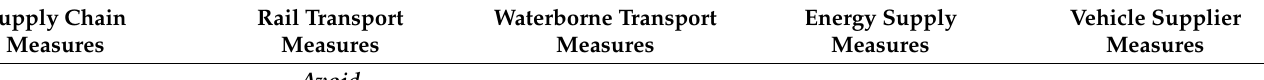
Table 7. Comparison of Irish and International Policy Measures for Sustainable Freight